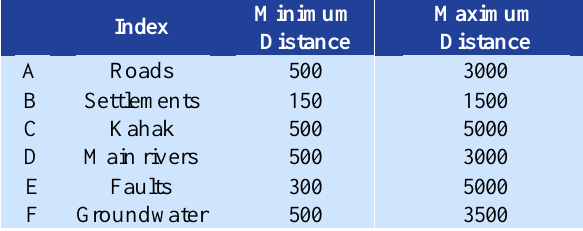
Table 2. Minimum and maximum distance for wastewater treatment plant site for defining fuzzy membership